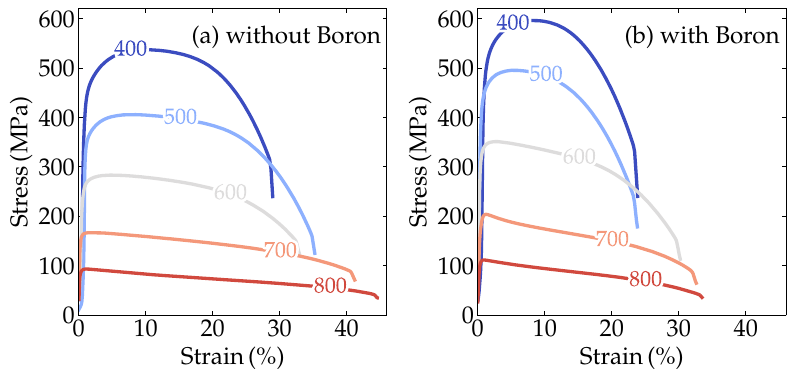
Figure 3. Engineering stress-strain curves at high temperatures for the alloy ( a ) without boron and ( b ) with added boron.